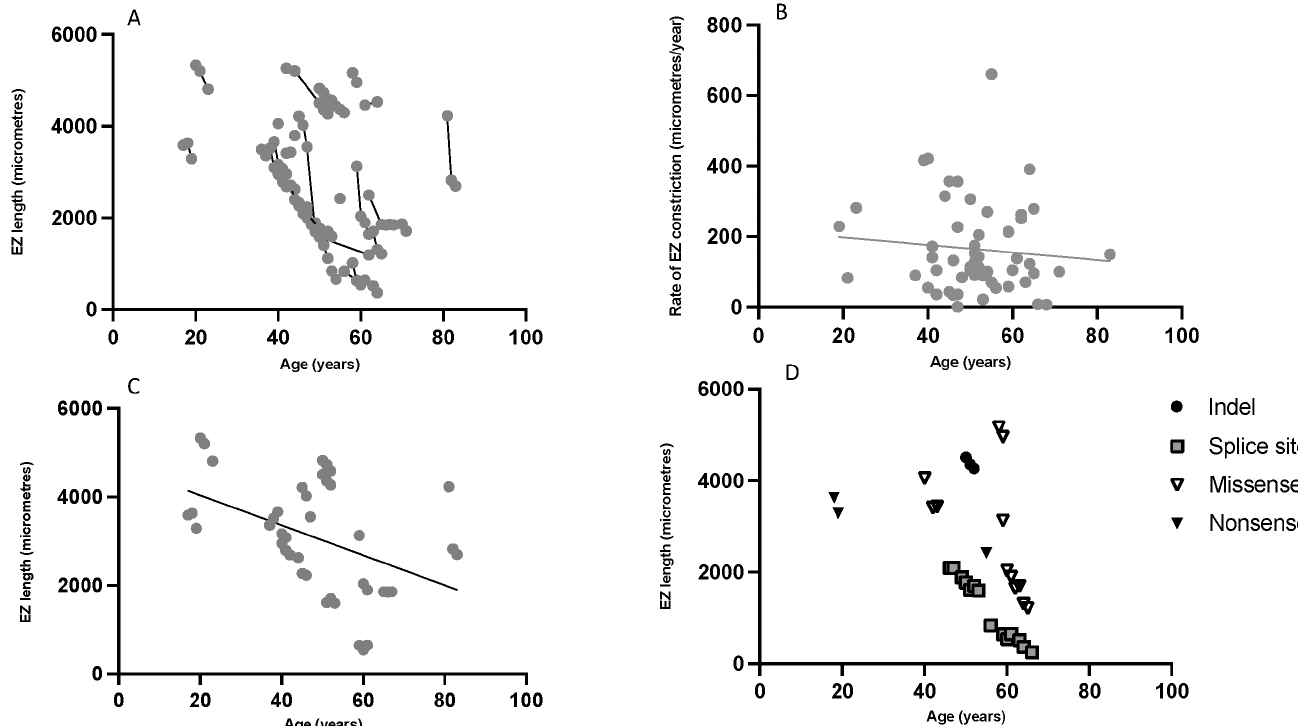
Figure 3. Ellipsoid zone (EZ) length analysis in patients with CNGB1 -related retinitis pigmentosa. ( A ) Correlation between EZ length and age for each patient at each visit showing a reduction in EZ length. ( B ) EZ constriction rate (change in size divided by time between visits), which appears to be constant with age. ( C ) Correlation between EZ length and age for patients who had three visits, each visit between 10–14 months apart ( n = 14) with a fitted linear trend that was statistically significant using Pearson correlation ( R 2 = 0.194, p = 0.004). Fifty seven percent (8/14) had a reduction of EZ length of 250 µm or more during the two year simulated trial period. ( D ) Correlation between EZ length and age for each patient per visit for each homozygous mutation subtype (insertion/deletion ‘Indel’, splice site, missense, and